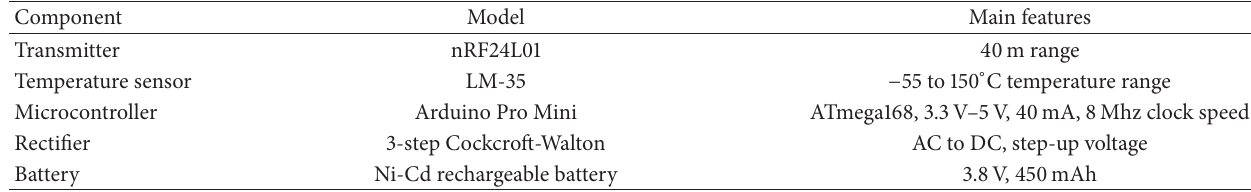
Table 3: Components of devised WTSN for transformer’s temperature